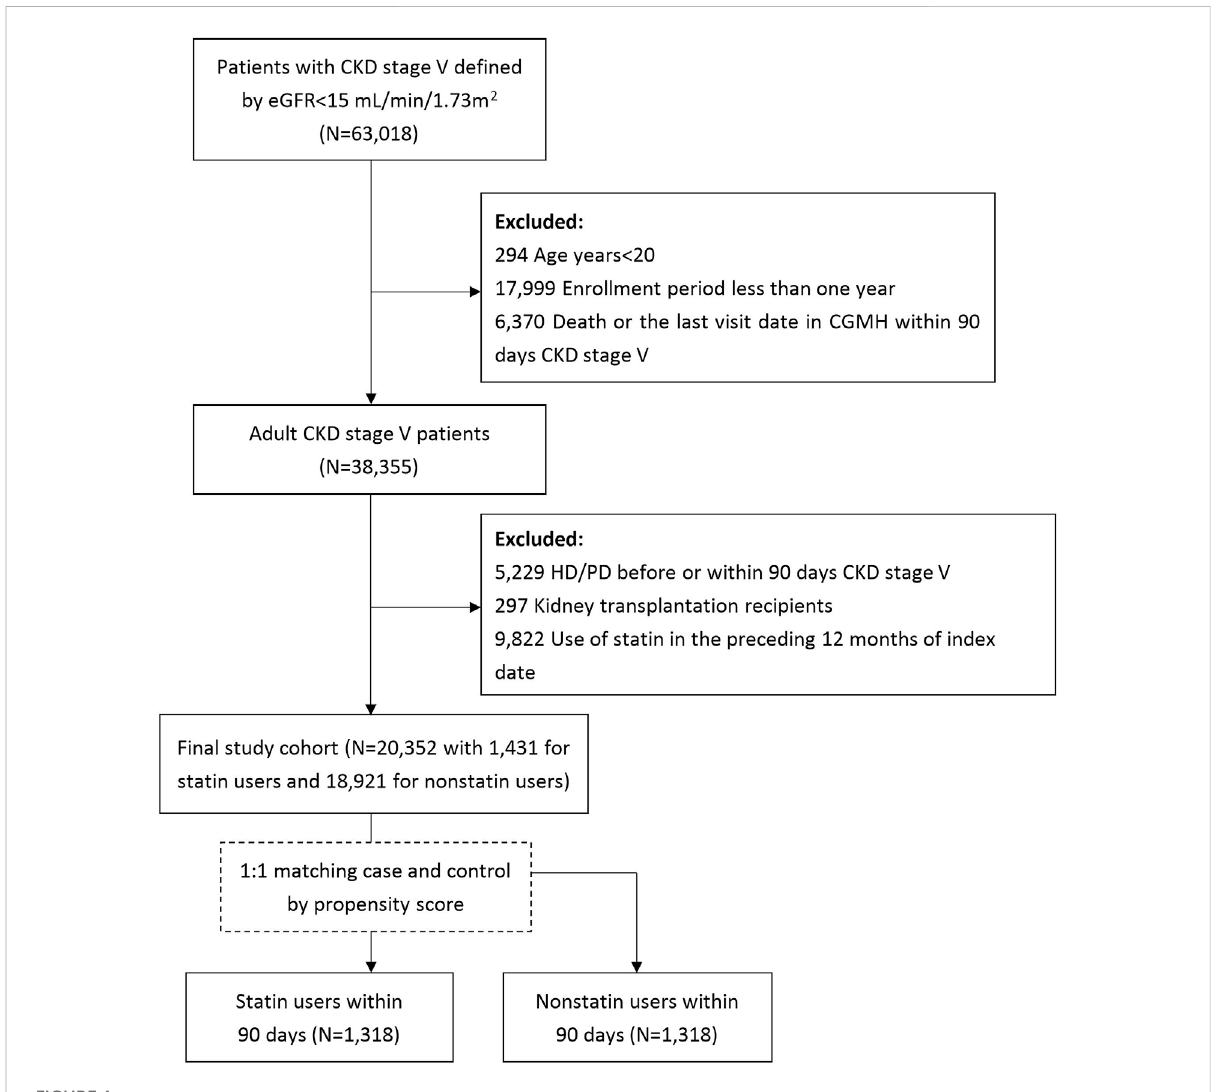
FIGURE 1 Selection process of study